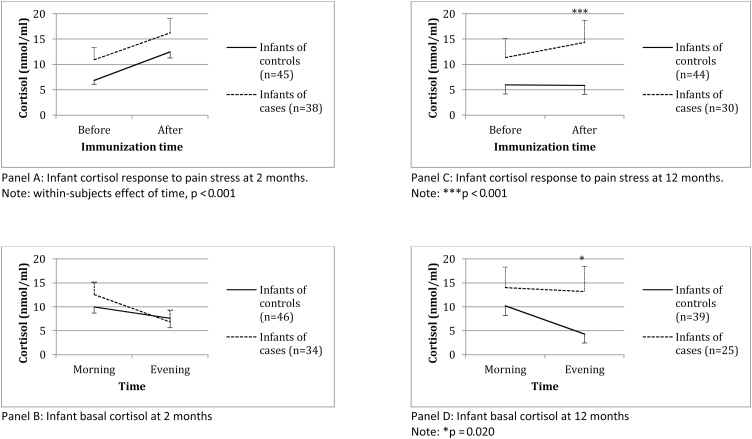
Infant cortisol at 2 and 12 months.